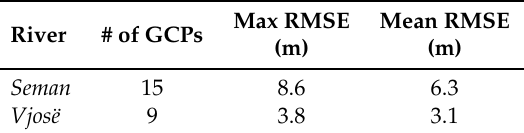
Table 3. Number of GCPs and Root Mean Square Errors (RMSEs) of the transformation applied to locally rectify